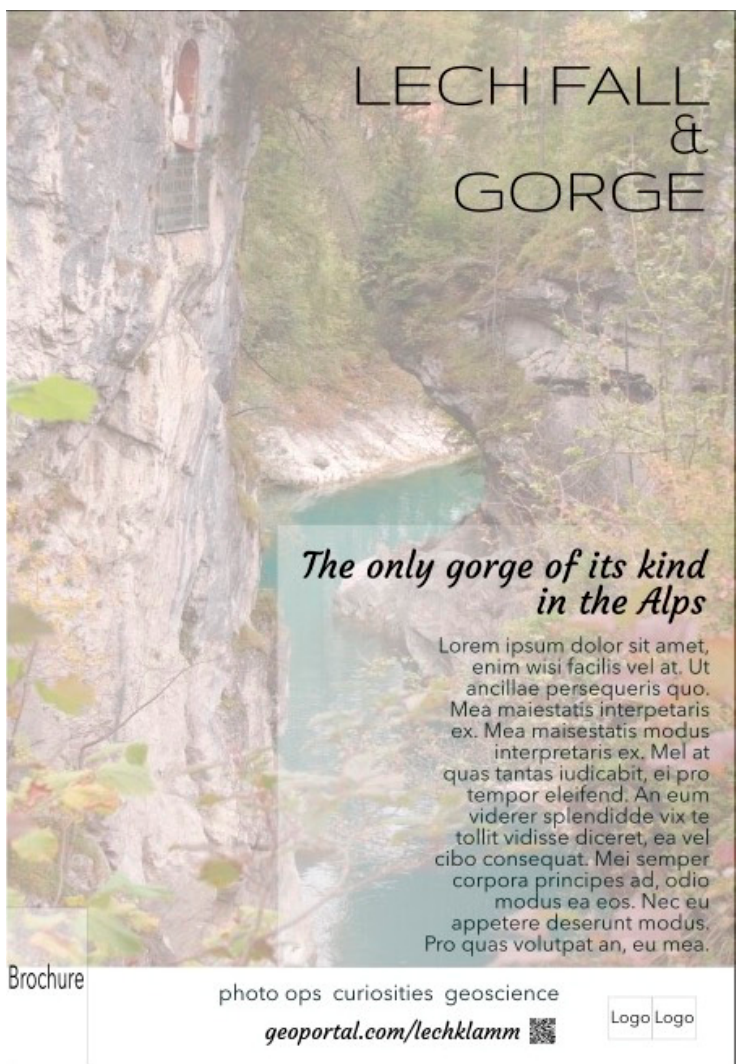
Figure 7. This is a second rough sketch of the template in progress. The existing brochure from the Bavaria’s Most Beautiful Geosites series (see Figure 2a) can be employed. Again, the image in the photo guides the eye and does not need to be fully visible. The waterfall opposite the gorge could be served by a second sign to describe historic tales, biological anomalies, or other engaging information. Their relatively small size means several can be installed without causing the Schilderwald effect.